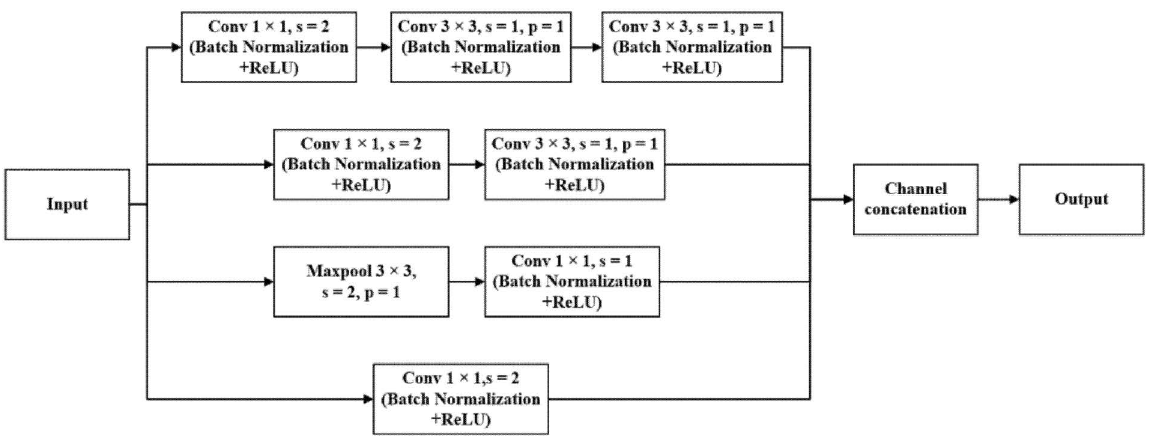
Figure 6. Inceptionv2